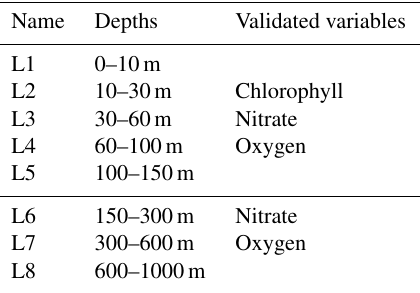
Table 2. Names, depths, and variables used for the eight layers em- ployed in the